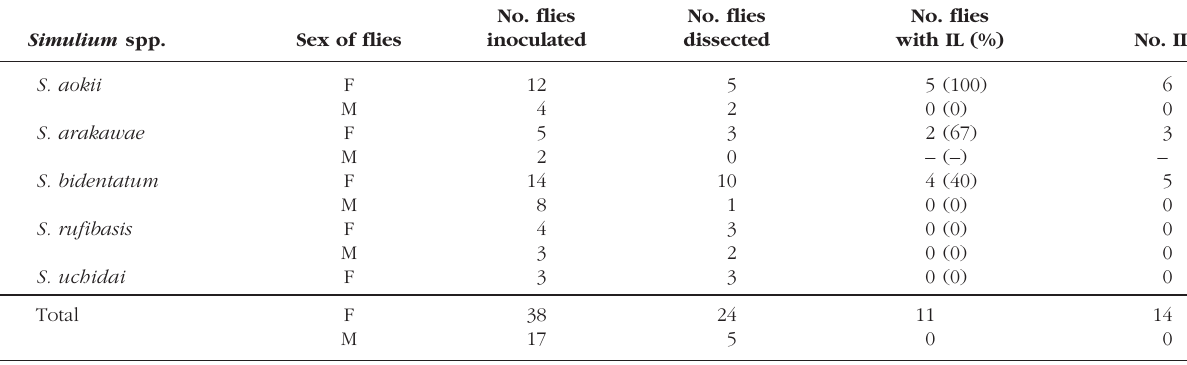
No. flies No. flies